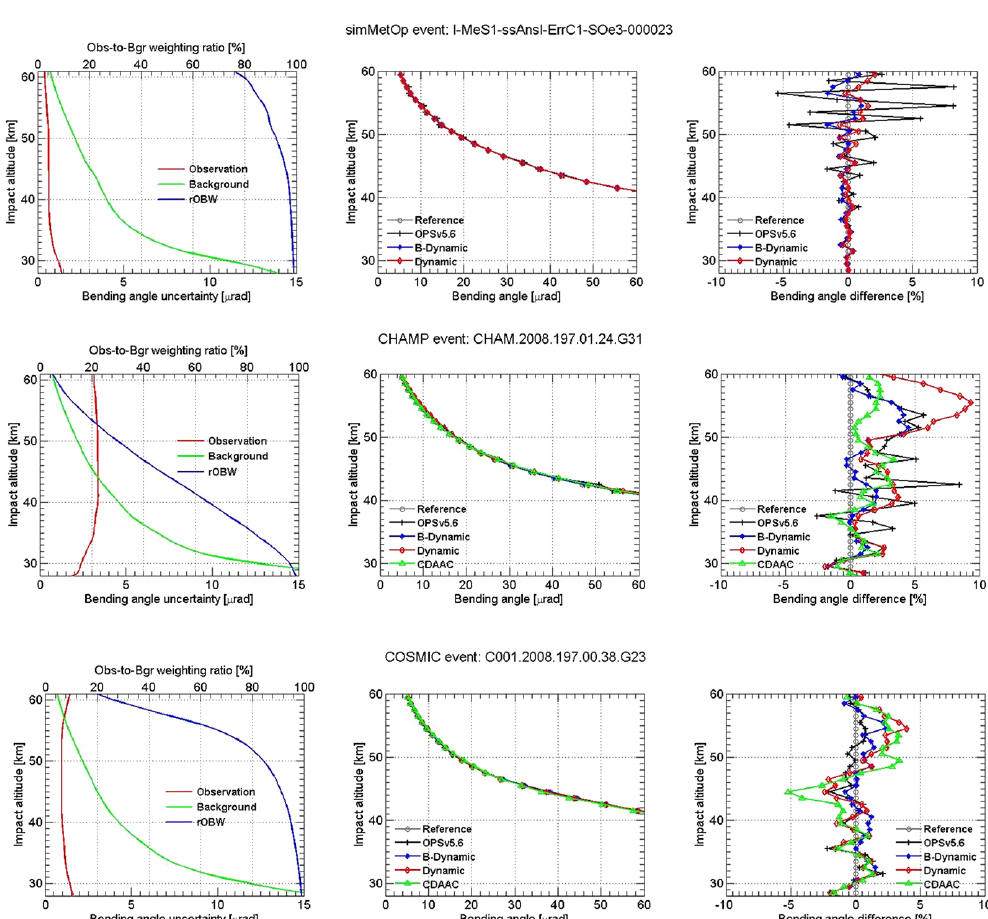
Figure 6. Background and observation bending angle uncertainty profiles as well as observation-to-background (Obs-to-Bgr) weighting ratio (left); statistically optimized bending angle profiles from the OPSv5.6, b-dynamic, dynamic, and CDAAC algorithms together with their reference profile (middle); and difference of the optimized profiles to the reference profile (right). Three example events from 15 July 2008 are illustrated, from simMetOp (top), CHAMP (middle), and COSMIC (bottom),